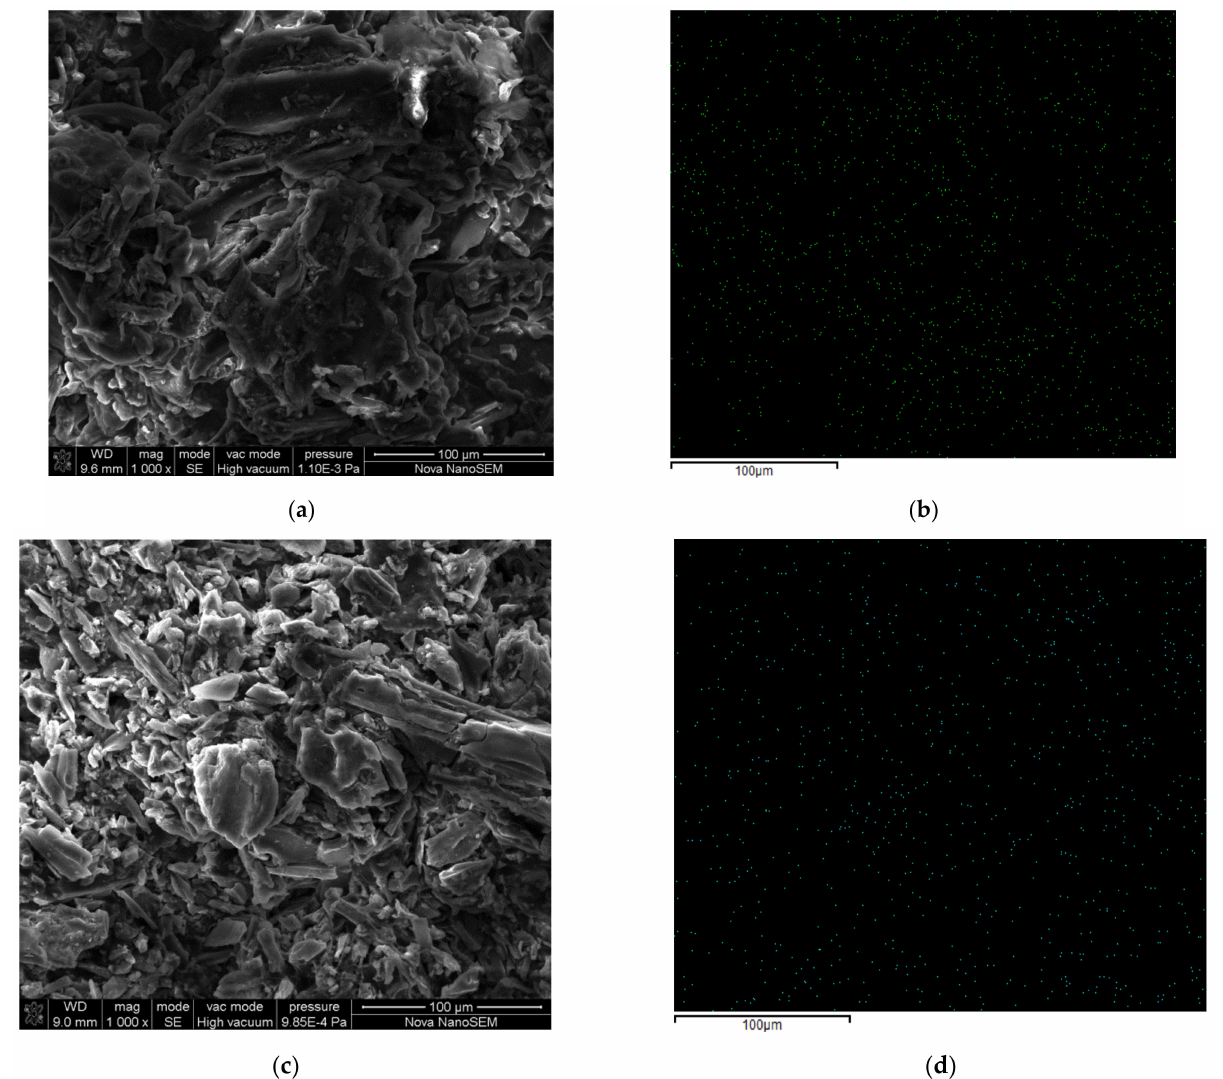
Figure 9. ( a ) raw T-BSA; ( b ) N elemental mapping of T-BSA; ( c ) T-BSA after Cr(VI) removal; ( d ) Cr elemental mapping of T-BSA after Cr(VI) removal.